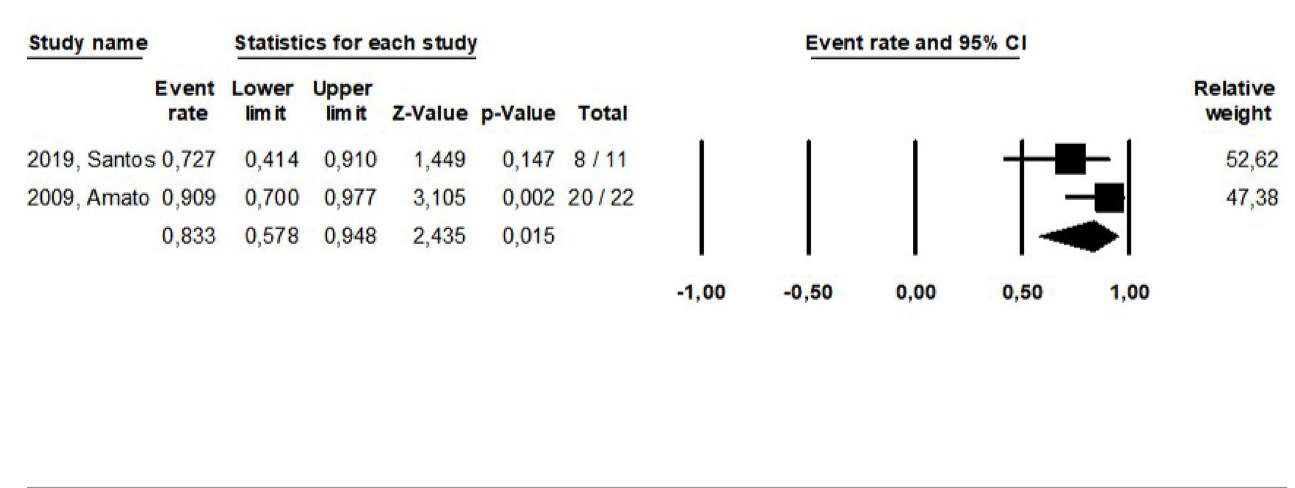
Fig 5. Pooled cure rate including all patients treated for ML with pentamidine in the reviewed studies.